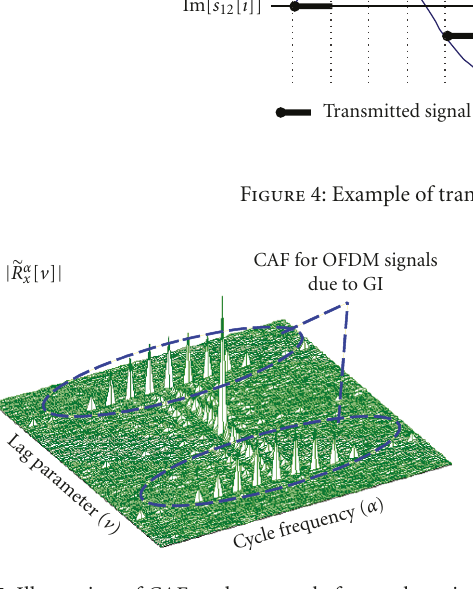
Figure 5: Illustration of CAF peak pattern before cyclostationarity induction.